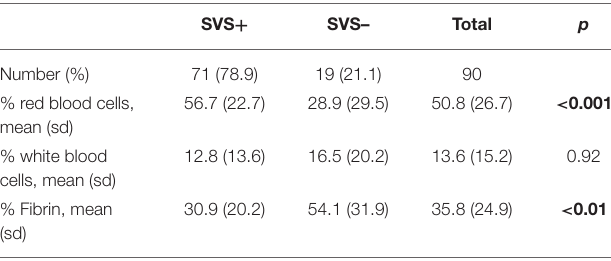
TABLE 2 | Multivariate analysis of the subgroup with known symptom onset time. TABLE 3 | Histopathological analysis of